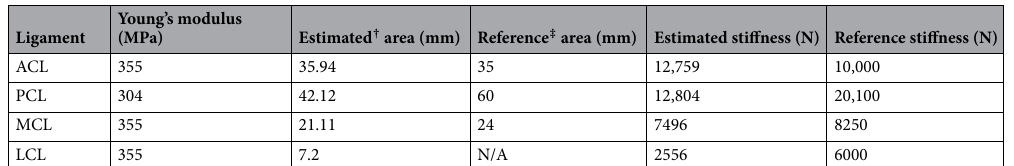
Table 1. Comparison of ligament parameters between estimated and reference literature values. The stiffness values are computed as the product of the cross-section area and Young’s modulus. from MRI data by applying PCA on the segmented geometries. acquired from 63